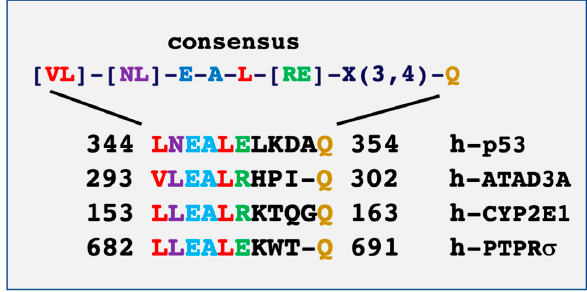
Figure 1. Sequence alignment of the S100B binding domains on p53 and ATAD3A defines a consensus sequence motif called NEAL motif. [20]. The consensus S100B-binding NEAL motif is present in the mitochondrial protein CYP2E1 and in the extracellular receptor protein RPTP σ .